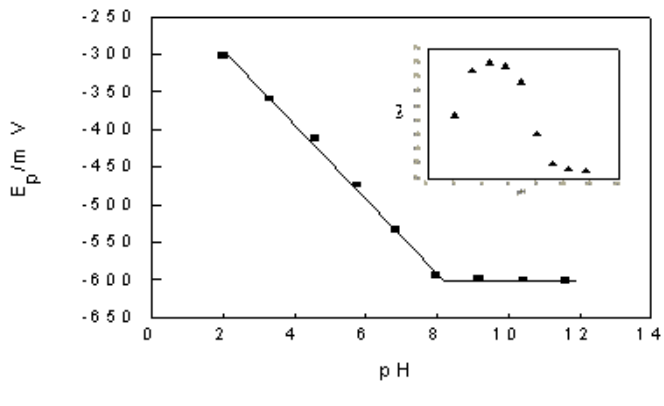
Figure 4. Effect of pH on the reduction potential and peak current of